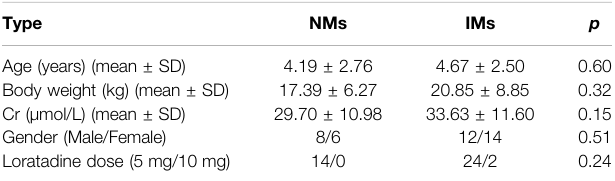
TABLE 2 | Comparison between NMs and IMs.